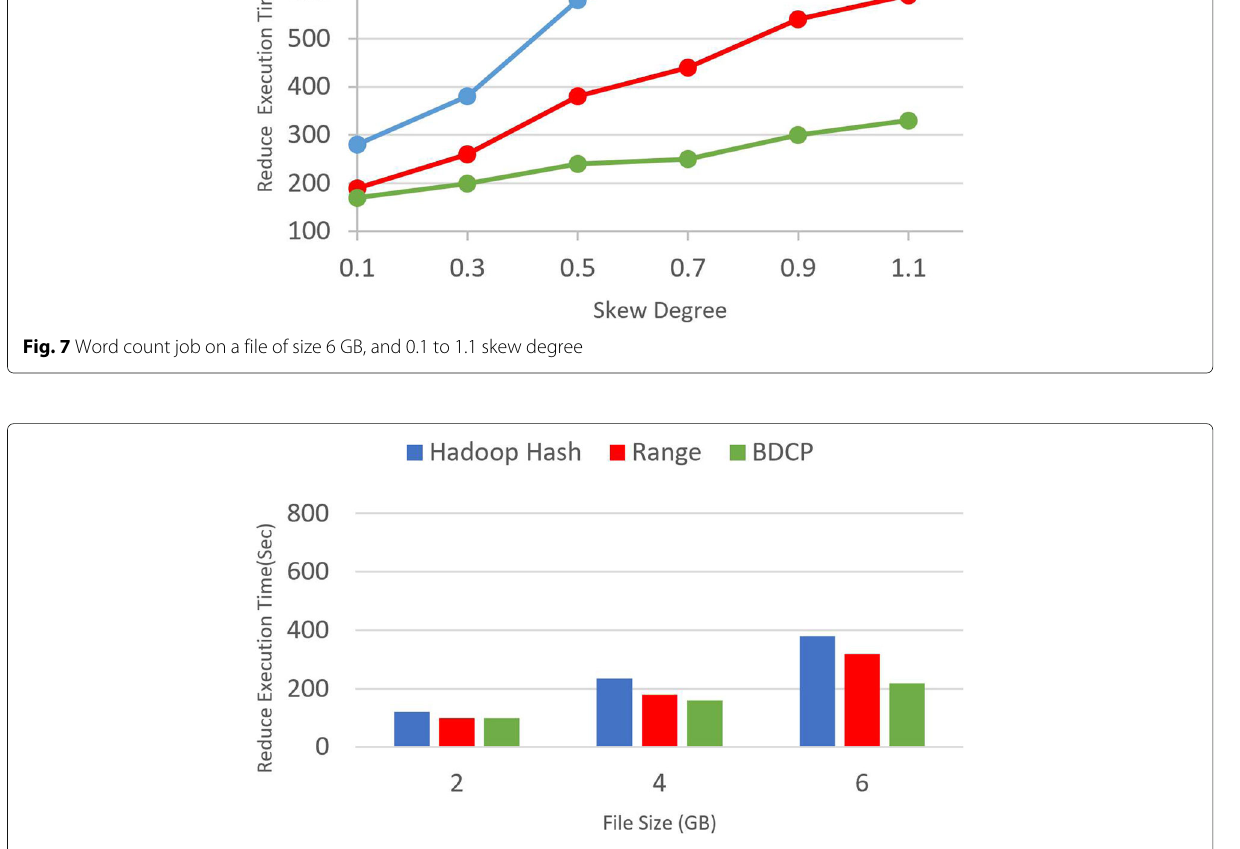
Fig. 8 Word count job on files of sizes, 2, 4, and 6 GB. skew degree is 0.1